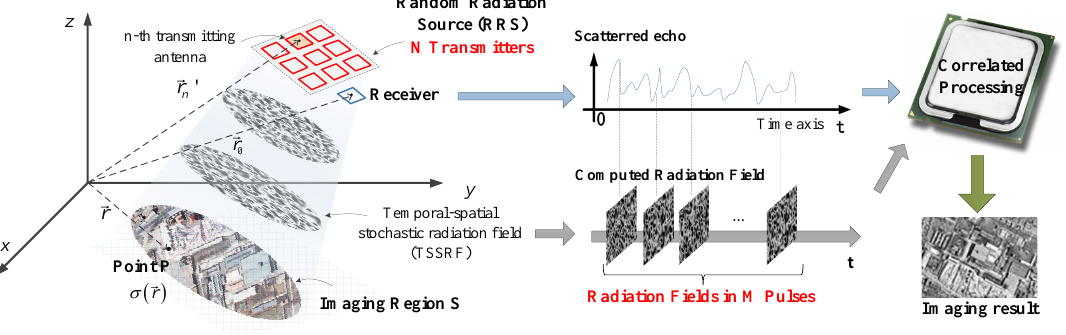
Figure 1. A typical geometry and basic process of Microwave Staring Correlated Imaging